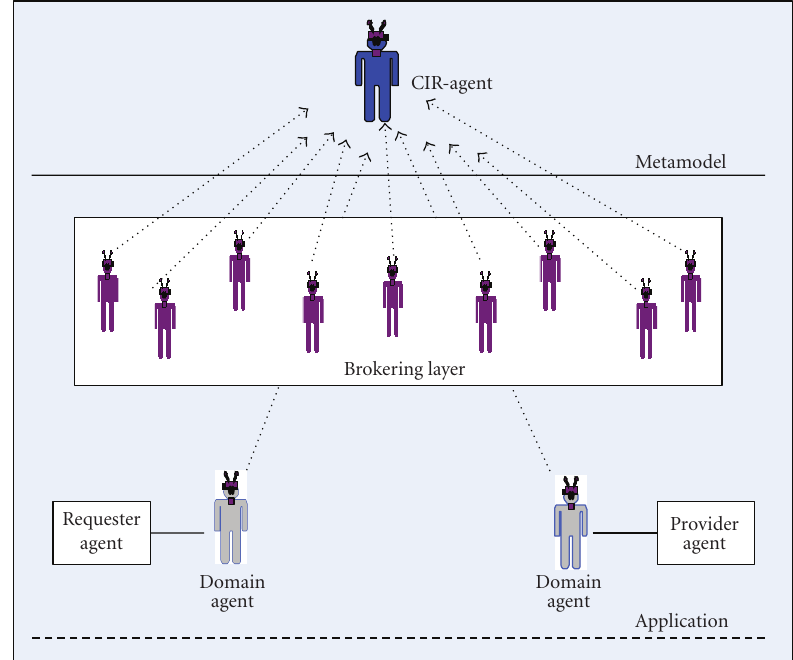
Figure 11: The overall system model.